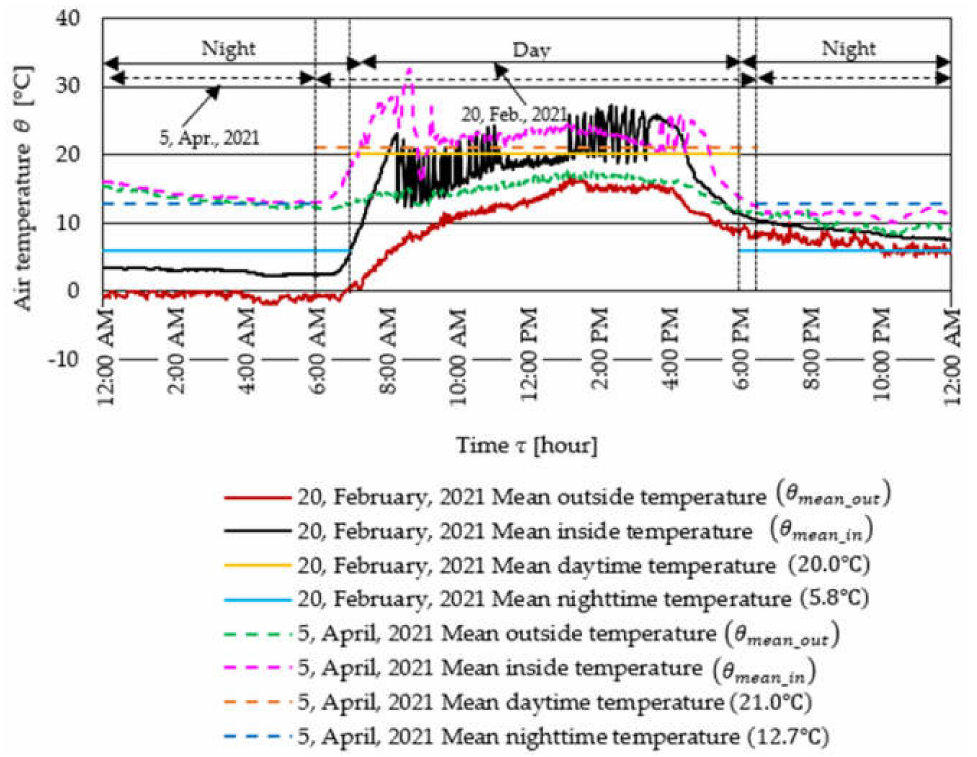
Figure 8. Variation in temperature inside and outside the greenhouse on each